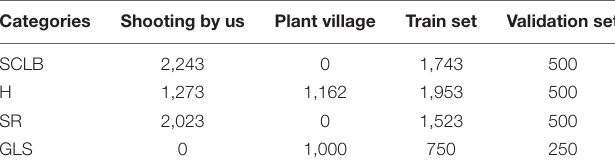
TABLE 1 | Distribution of data sources and division of training set and validation